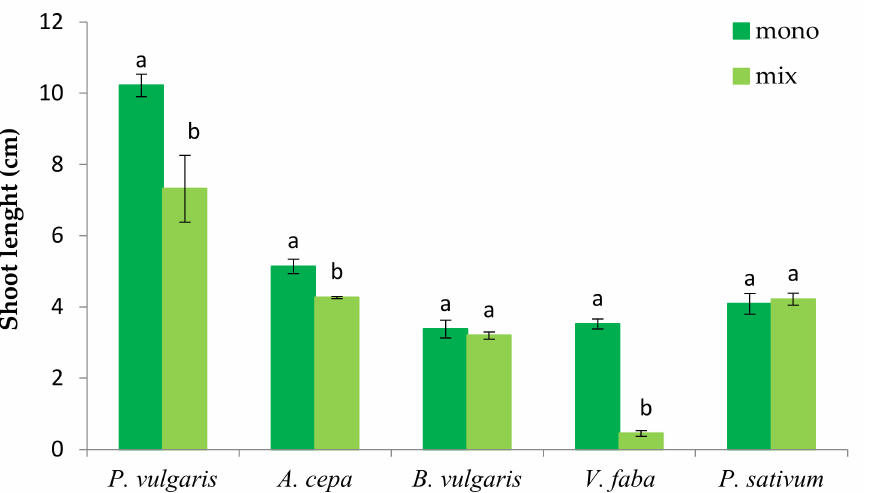
Figure 3. Shoot length of crop species grown together with P. oleracea seeds (mono = only crop plant; mix = crop grown together with P. oleracea ). Bars represent the means of 4 replicates ± SE. Bars topped by the same letter indicate no significant differences between treatments at the 5% level using Duncan’s multiple-range